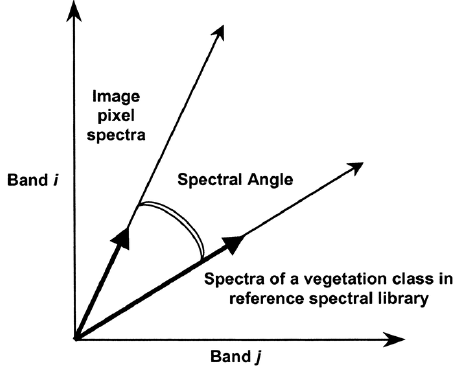
Figure 4. Representation of reference angle [33].